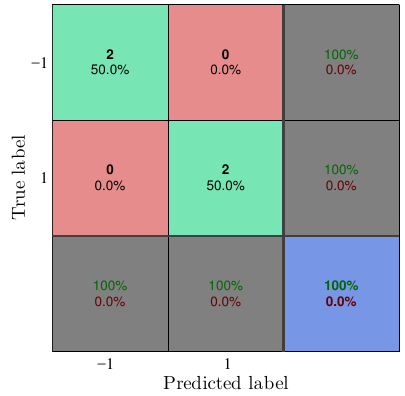
Figure 6. Confusion matrix of the XOR training, software implementation.